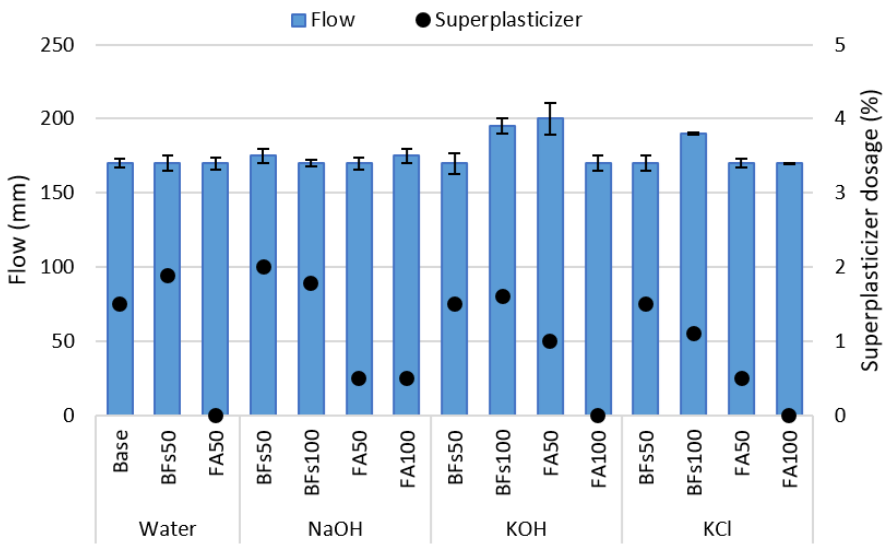
Figure 2. Flow of samples with KCl separated from CBD, NaOH and KOH as